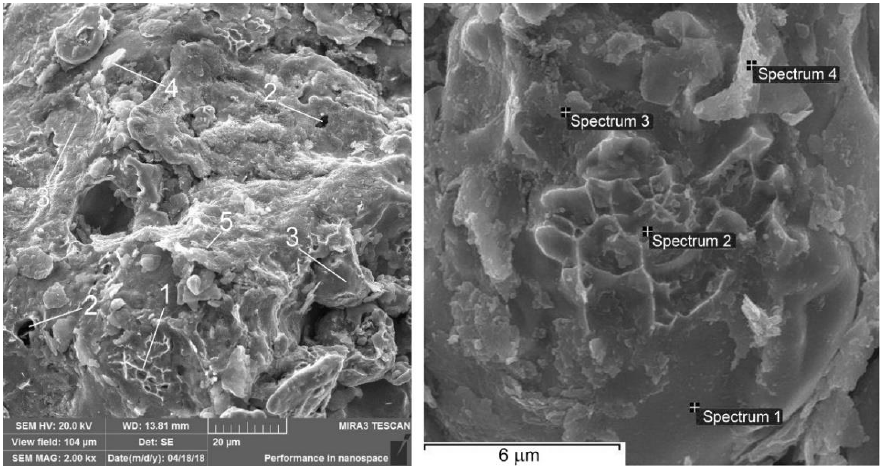
Figure 9. Fractographies of FeGr1 with 1 wt% Al 2 O 3 particulates: 1—areas of transcrystalline quasi-brittle fracture; 2—pores; 3—areas of brittle cleavage; 4—Al 2 O 3 particulate; 5—microcrack.